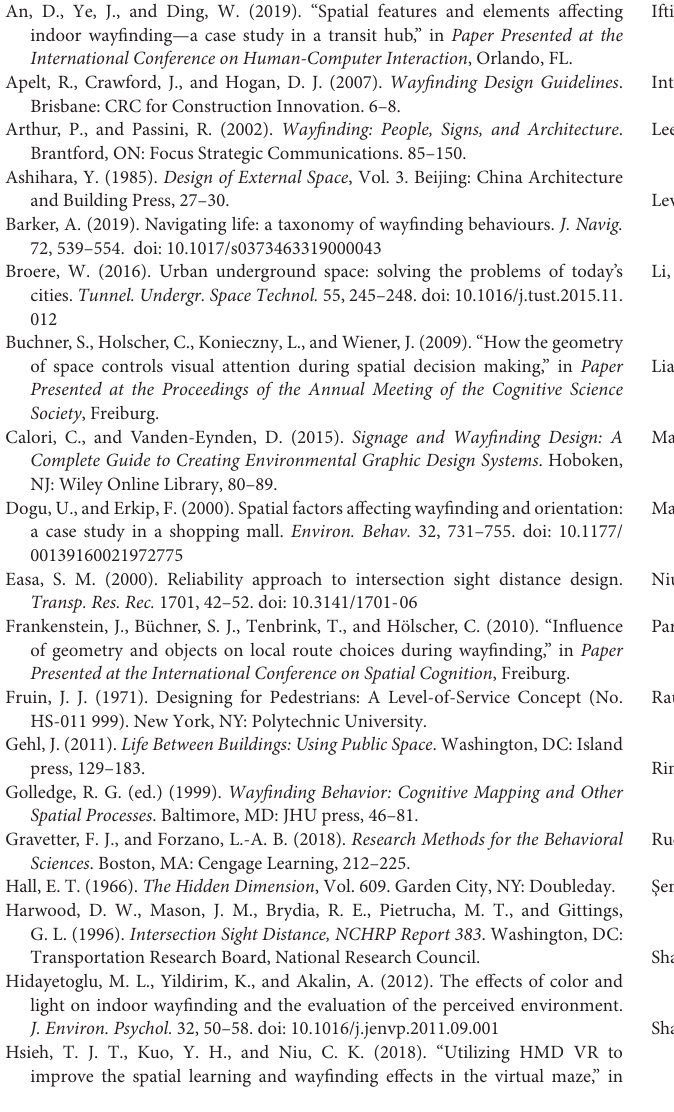
Supplementary Figure 2 | Curved corners improve driver confidence when cornering or going straight (cf., Easa, 2000). Supplementary Figure 3 | Details of the operational procedures. Supplementary Figure 4 | Blueprint code used to guide the wayfinding simulation. Supplementary Figure 5 | Blueprint timing function code of UE4. Supplementary Figure 6 | 50% is a theoretical threshold between left- and right-turn performance (Raubal and Egenhofer, 1998). Supplementary Figure 7 | Time cost versus right-turn performance. Supplementary Table 1 | Wayfinding empirical studies involving corridor configurations. Supplementary Table 2 | Specific parameters of the virtual